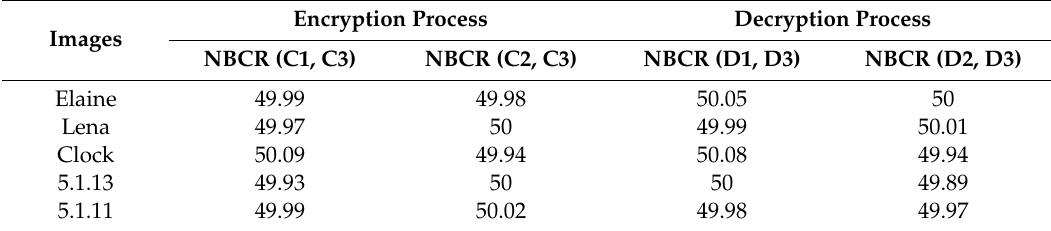
Table 8. NBCR values of sample images in the encryption and decryption processes.